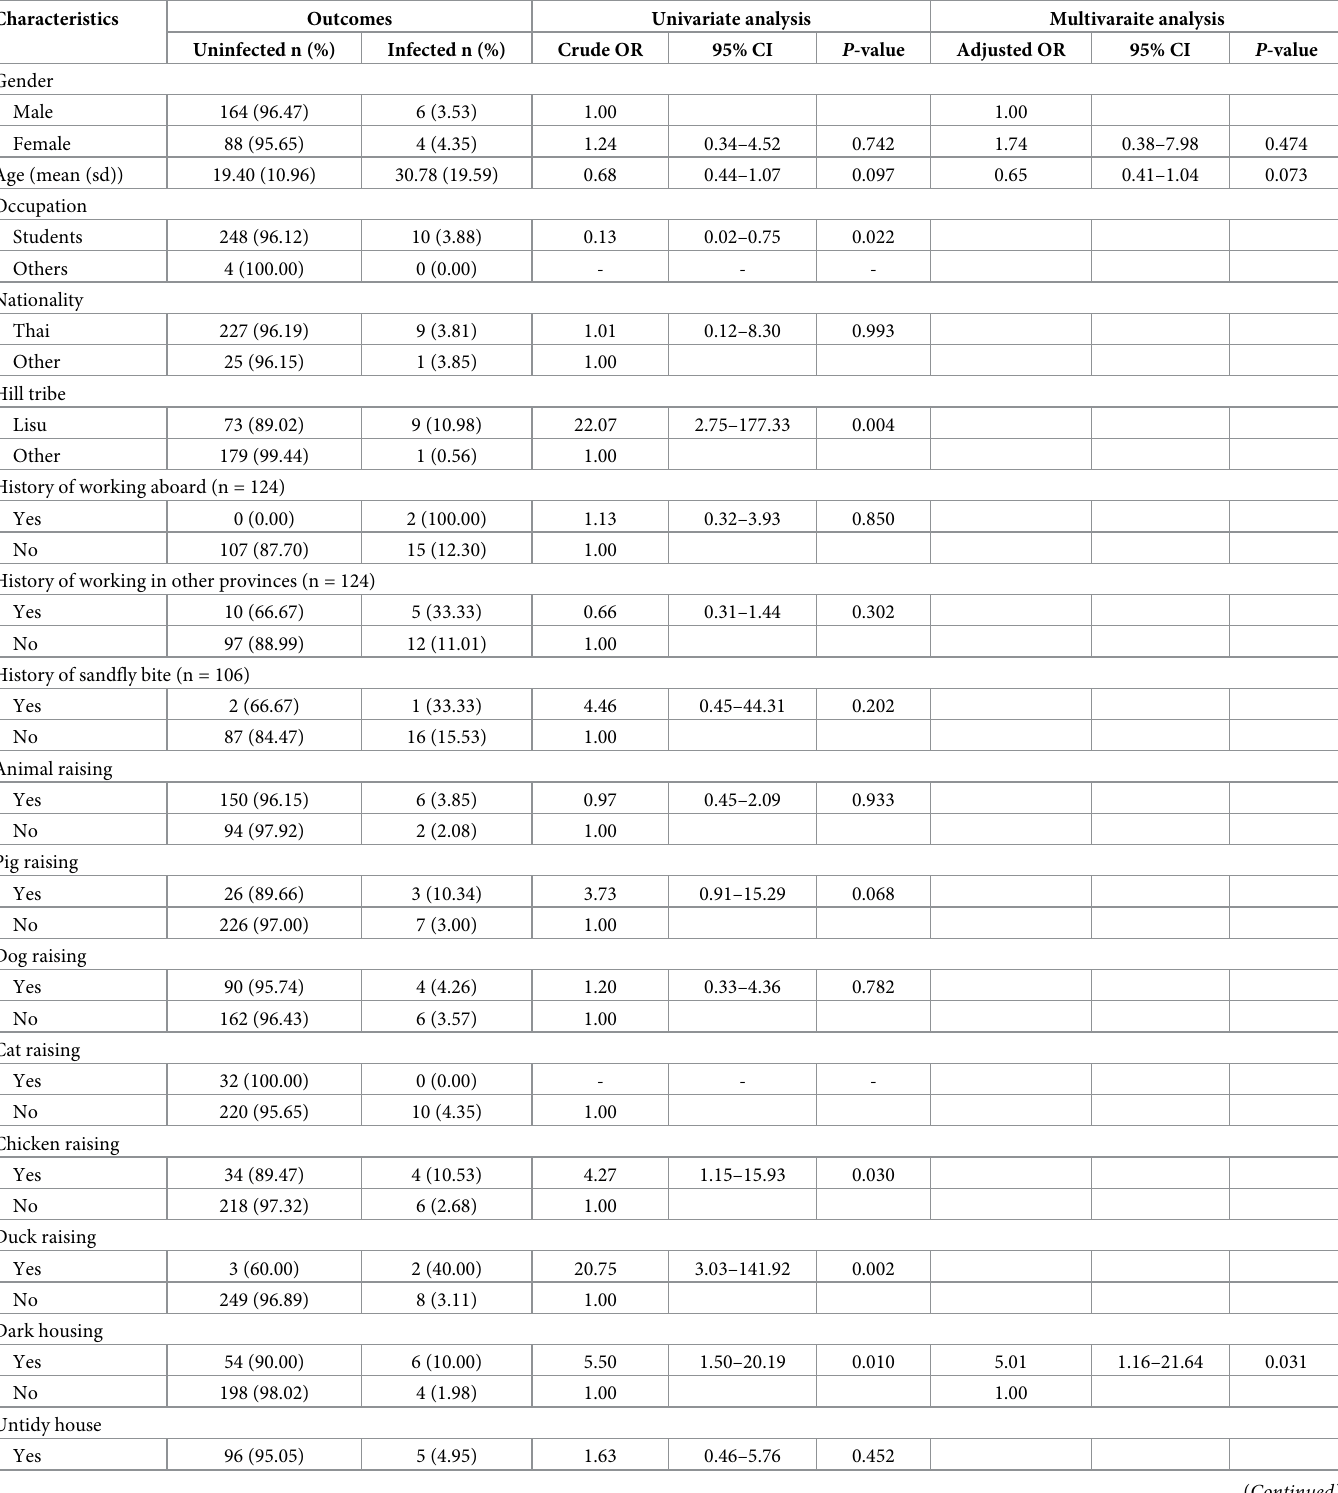
Table 5. Univariate and multivariate analysis of risk factors of Leishmania infection among patients in Vocational school (Amphoe Mueang Chiang Rai District), Chiang Rai, Thailand (n = 262).